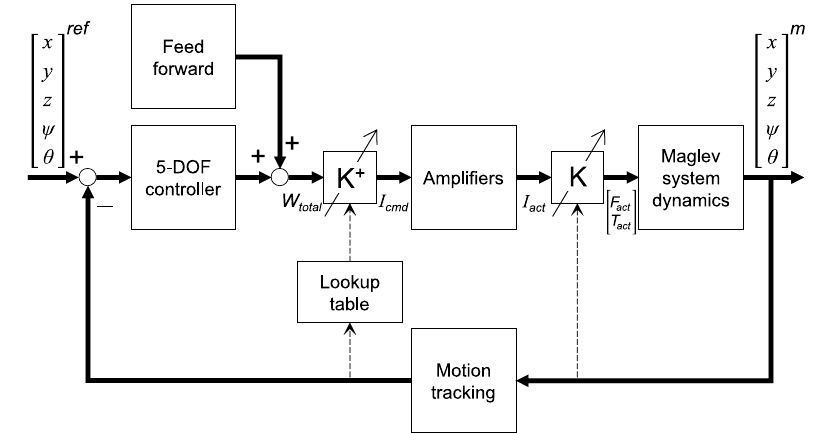
Figure 10. Five-DOF control